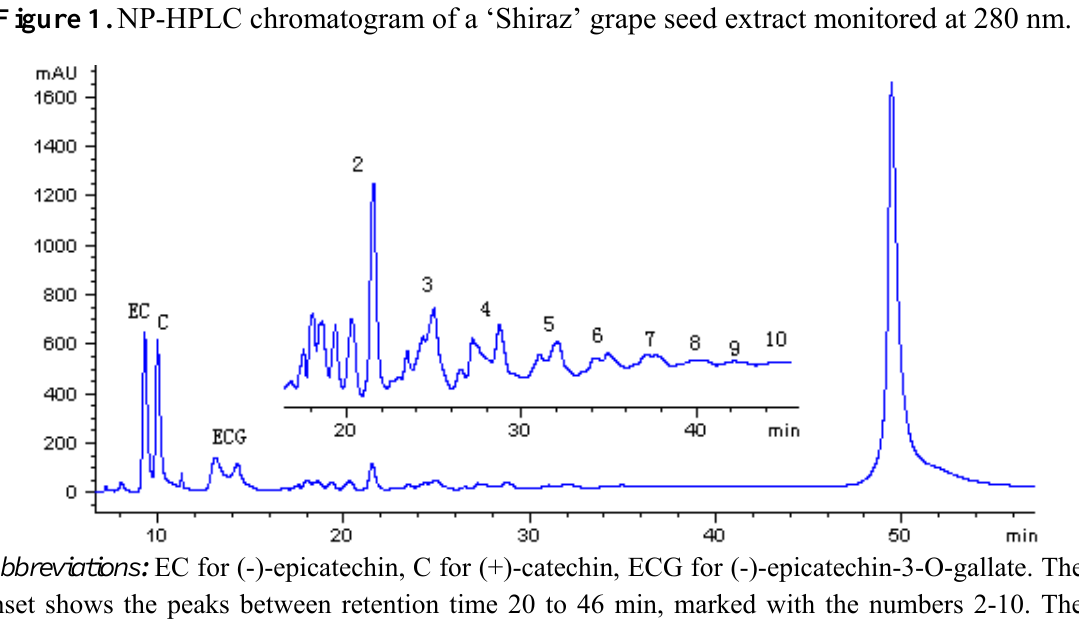
Figure 1. NP-HPLC chromatogram of a ‘Shiraz’ grape seed extract monitored at 280 nm.